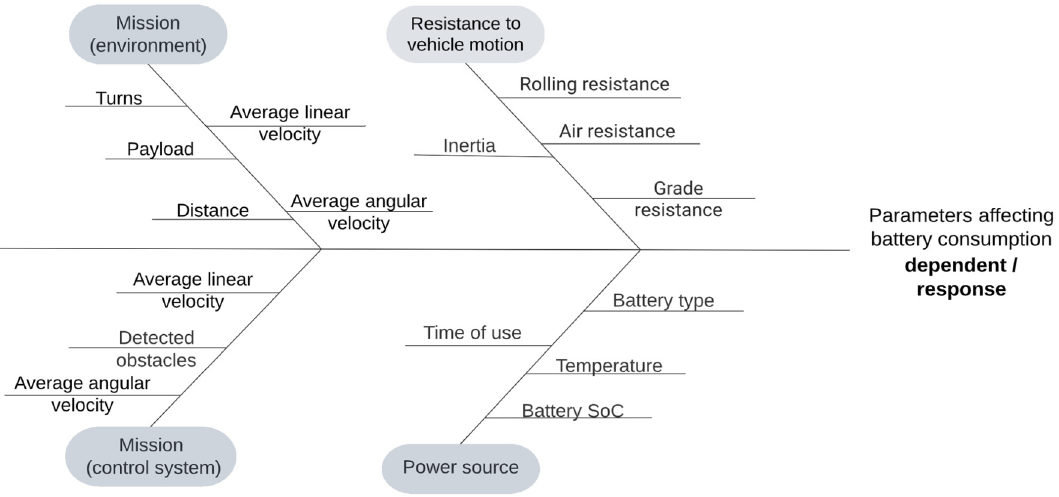
Figure 1. Ishikawa diagram—parameters that may affect energy consumption during mission execution.